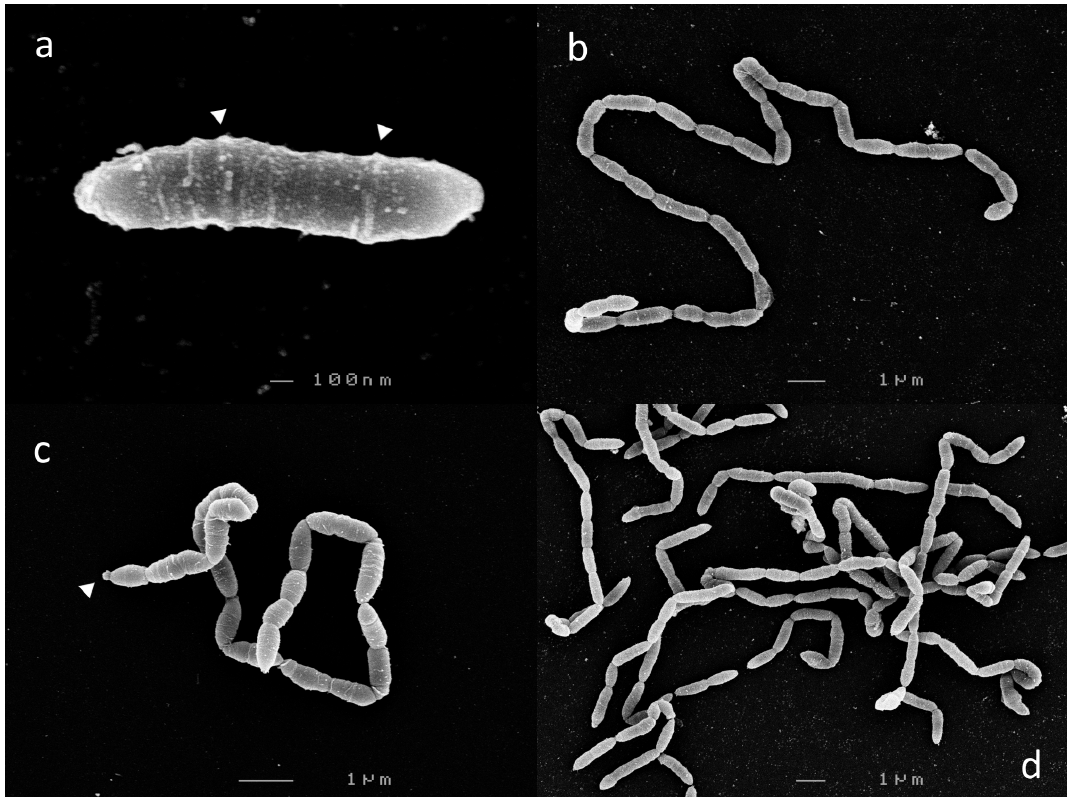
Figure 2. Scanning electron micrographs of Eubacterium sp. c-25. Observed morphological states: ( a ) single-cell, ( b , c ) filamentous, and ( d ) entangled filaments. Visible extracellular structures are indicated by white arrows. Images shown were taken after 6 h ( a , b , d ) or 12 h ( c ) of